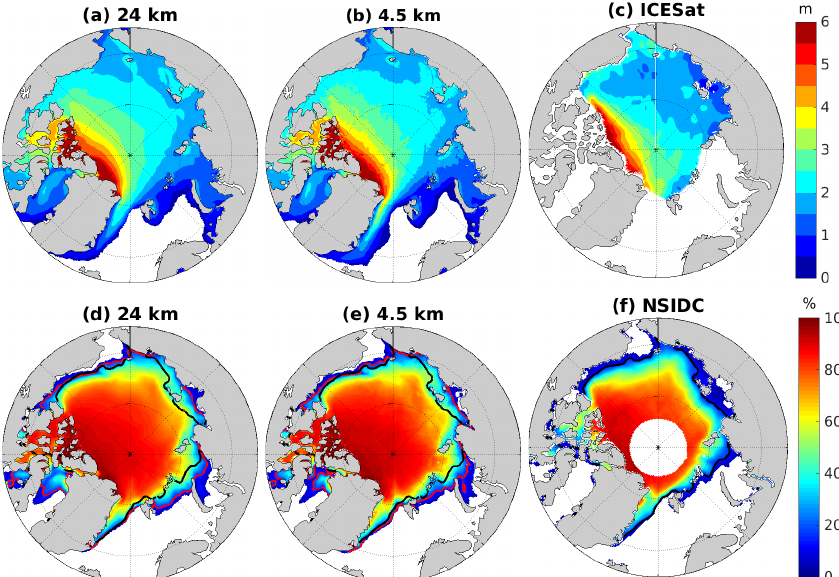
Figure 14. Spring sea ice thickness averaged from 2004 to 2007 for (a) simulations LOW, (b) HIGH, and (c) the Ice, Cloud, and land Elevation Satellite (ICESat) observation (Kwok et al., 2009). September sea ice concentration averaged from 1979 to 2009 for (d) simulations LOW, (e) HIGH, and (f) the US National Snow & Ice Data Center (NSIDC) observation (Fetterer et al., 2016). In panels (d, e) , the black curves show the 15% contour lines of the observed sea ice concentration, while the red curves show those of simulations. The periods when both observations and model results are available are chosen for calculating the